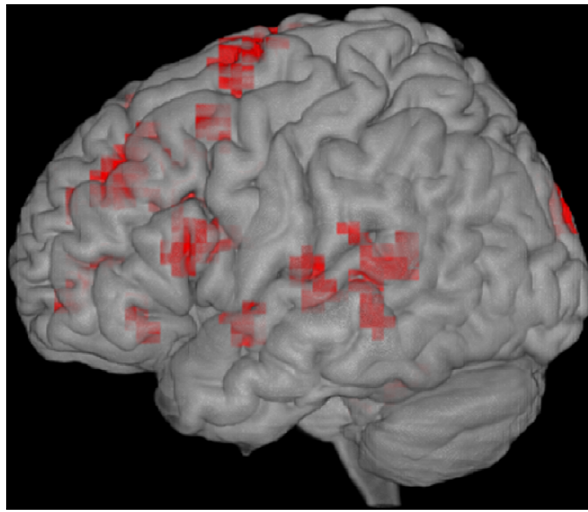
Figure 1. Activations in proficient deaf readers for words versus false fonts, p ,